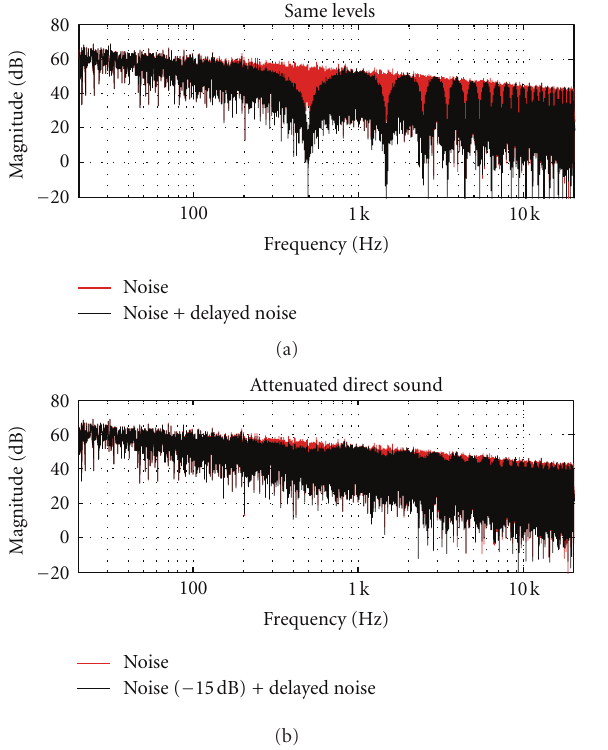
Figure 18: Comb filtering e ff ect with the delay of 3 ms. The red curve represent the spectrum of pink noise and the black curve represents the spectrum of pink noise which is added to the delayed version of itself. (a) illustrates the comb filtering e ff ect, when the added signals have the same energy, whereas (b) illustrates the e ff ect when the passive attenuation of the ARA headset is